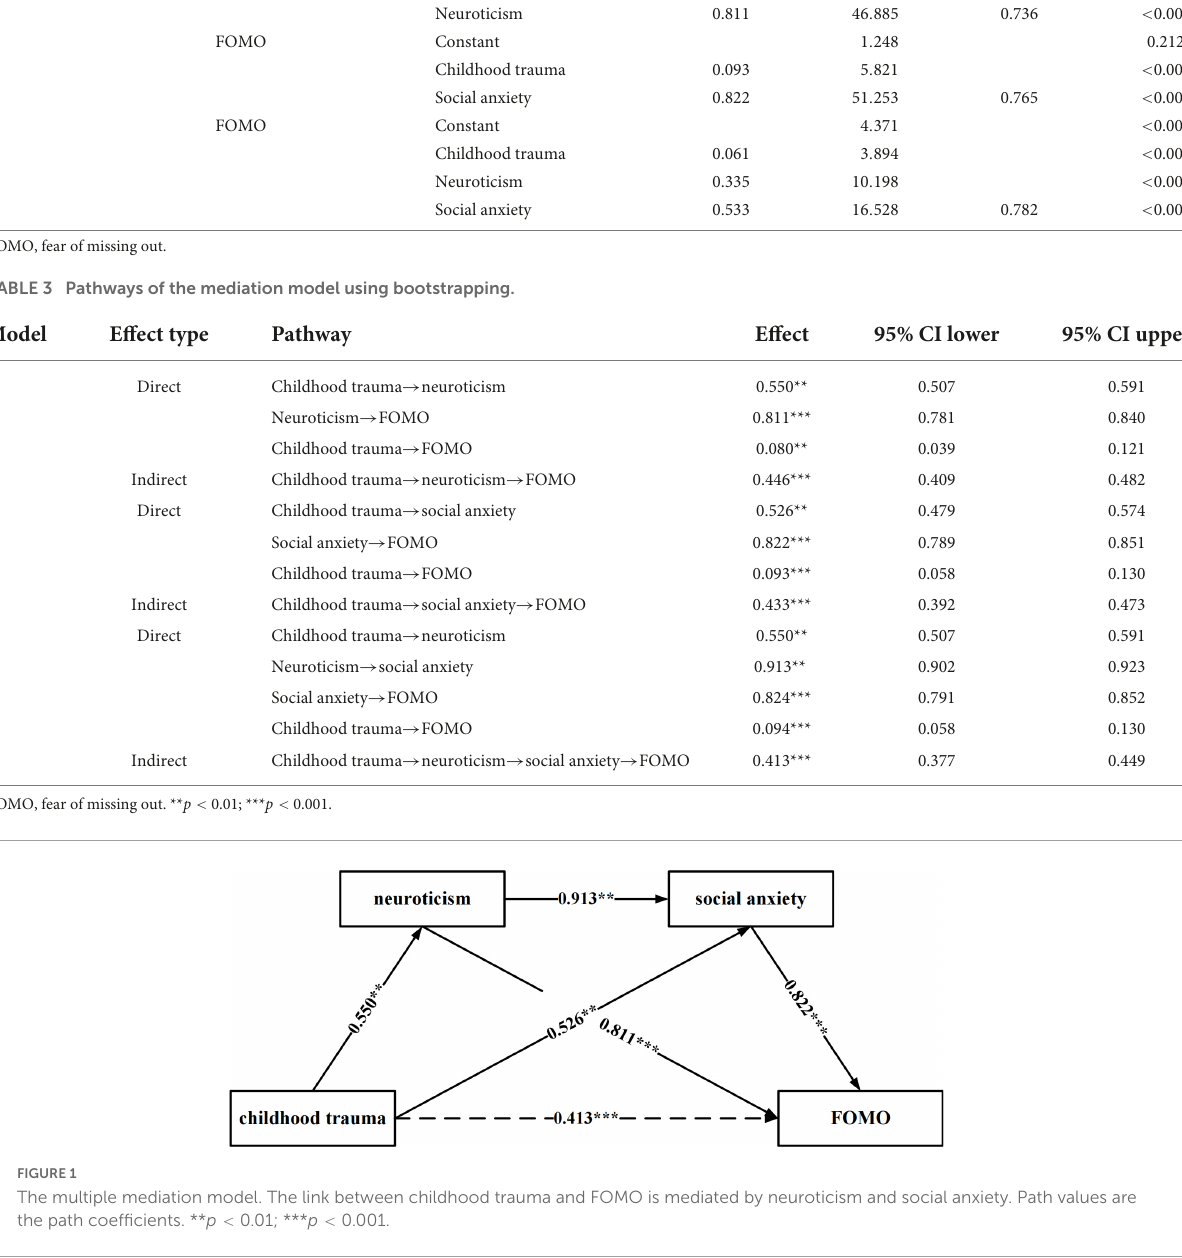
with neuroticism (21), and neuroticism positively affects FOMO (20). In this study, significant positive